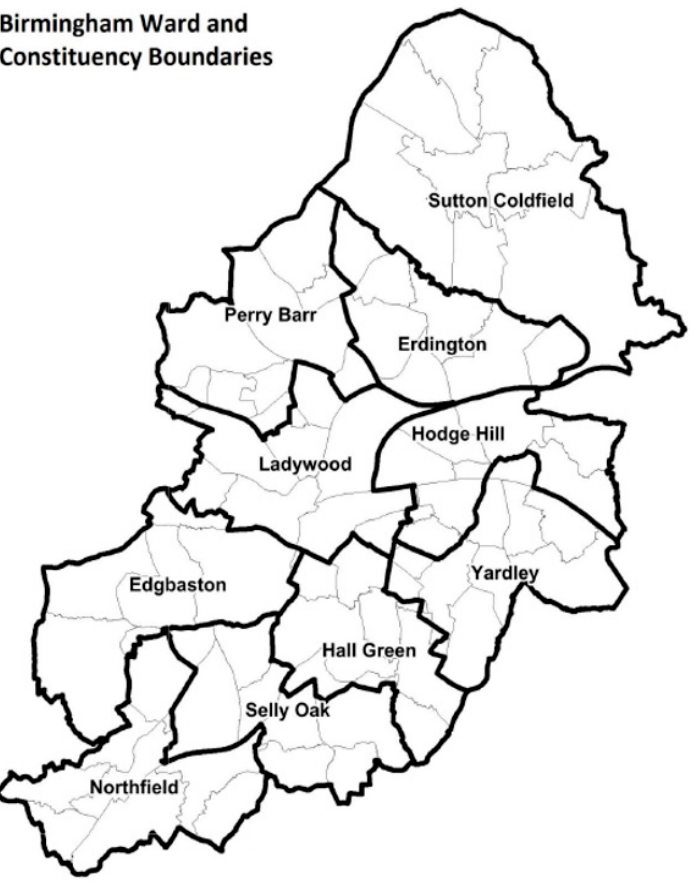
Figure 1. Birmingham ward and constituency boundaries map [29].